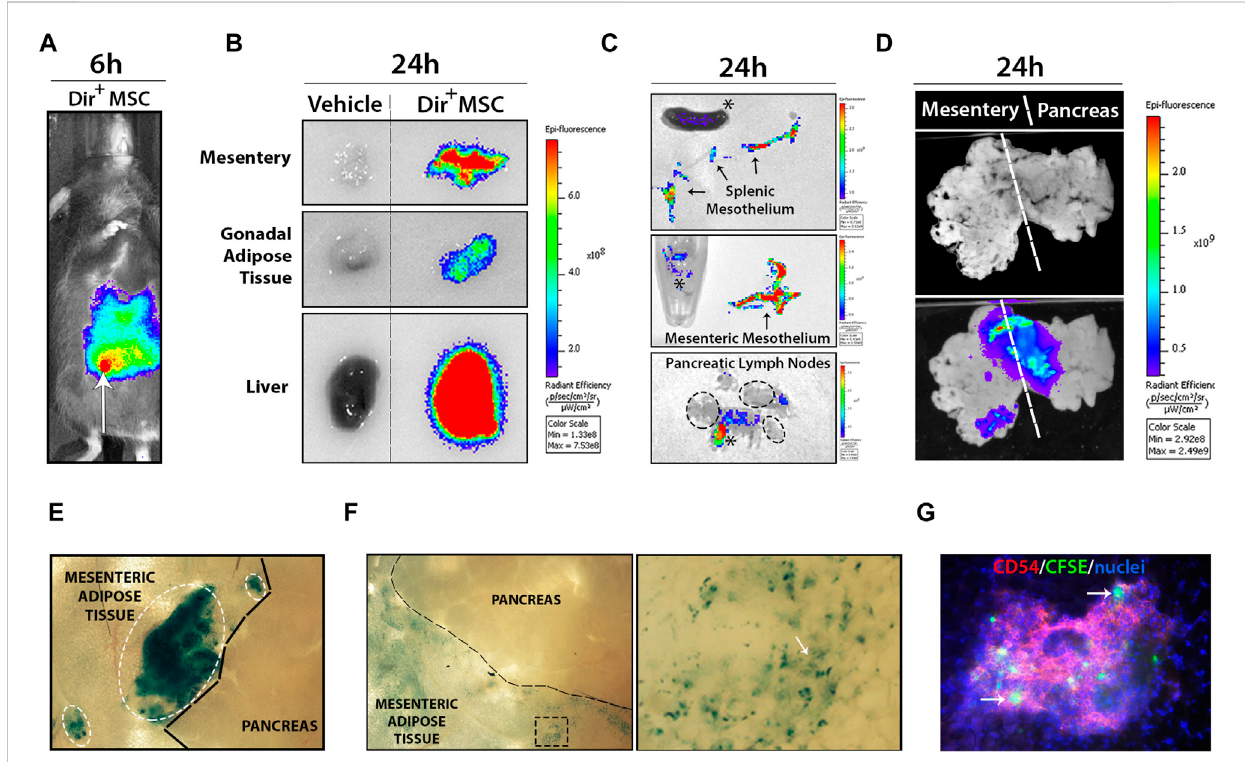
Transplanted UC-MSC rapidly spread inside the peritoneal cavity and adhere to the mesothelium surface of several peritoneal organs. (A) Shows wide dissemination of 5 × 10 5 Dir + UC-MSC through the peritoneal cavity at 6 h post-transplantation (arrow points to the injection site). (B) Shows comparative Dir + fl uorescence levels into mesentery, gonadal adipose tissue and liver section from vehicle or Dir + UC-MSC transplanted IMM mice, at 24 h post-transplantation. (C) Upper and middle images show comparative Dir + fl uorescence into the separated splenic and mesenteric mesothelium (arrows), respectively. Lower image shows Dir + fl uorescence signal in pancreatic lymph nodes (PLN), which was externally restricted to peripheral adipose tissue (asterisks), but not to PLN (ellipse). (D) Whole-mount visualization of connected mesentery and pancreas at 24 h post- transplantation of Dir + UC-MSC and after washing in PBS allows the visualization of small to large Dir + UC-MSC aggregates adhered on their surface. (E) En face bright fi eld picture of mesentery and pancreas surface at 24 h post-transplantation of Dir + UC-MSC, showing small to large blue Dir + UC-MSC aggregates (ellipses)adhered on top of the mesenteric adipose tissue mesothelium but not on top of the pancreatic mesothelium. (F) En face bright fi eld picture of mesentery and pancreas surface at 7 days post-transplantation of Dir + UC-MSC. At that time post-transplantation, Dir + aggregates were not observable on top of the mesentery surface (left image). By contrast, many areas of the mesenteric adipose tissue displayed residual Dir + dots in surface cells (enlarged spot). (G) En face immuno fl uorescence picture of the mesentery surface showing Dir + cells inside a milky spot (depicted by CD54-PE high lymphocytes) which should likely correspond to macrophages with internalized Dir +